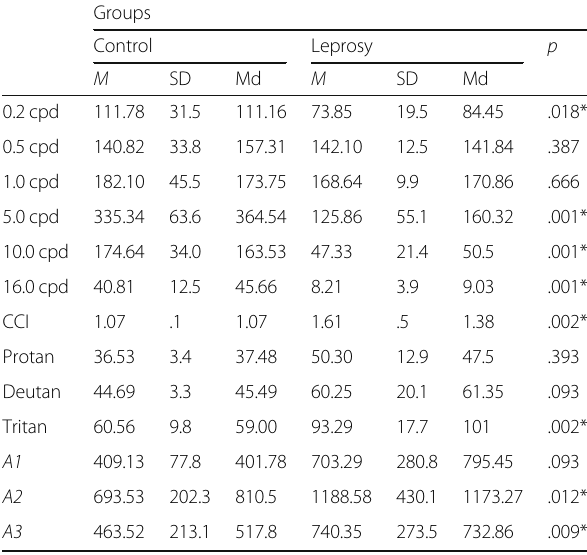
Table 1 Distribution of the mean (standard deviation) and median scores of the contrast sensitivity and color discrimination test (Lanthony D15d and CCT)